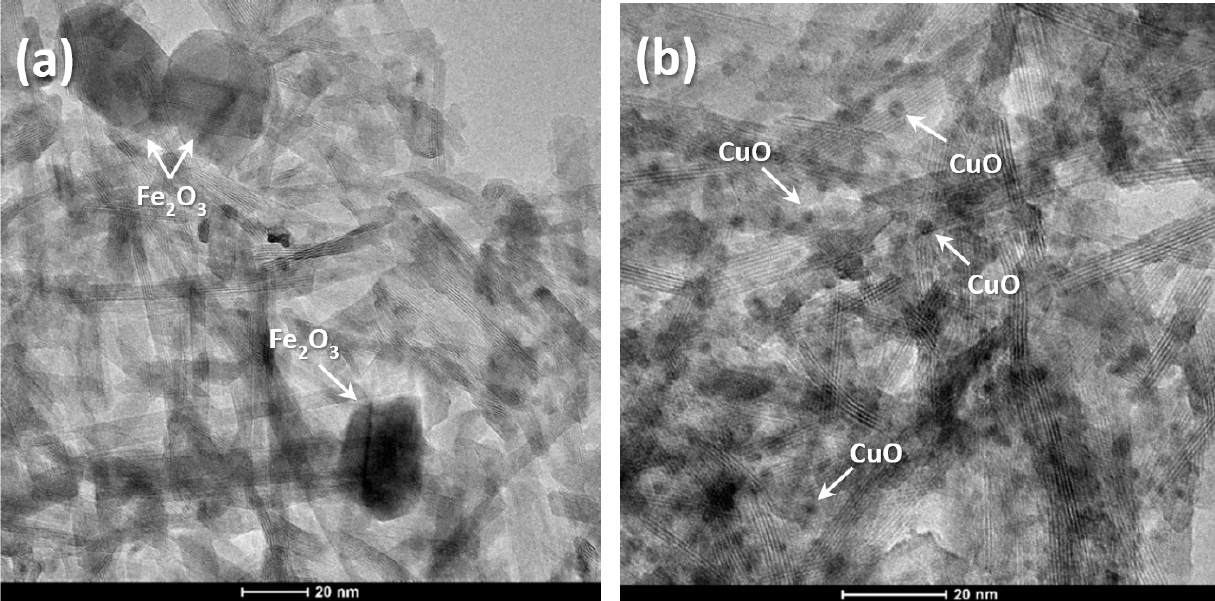
Figure 1. HRTEM images of TiO 2 NW@Fe 2 O 3 ( a ) and TiO 2 NW@CuO ( b ) nanocomposite samples.